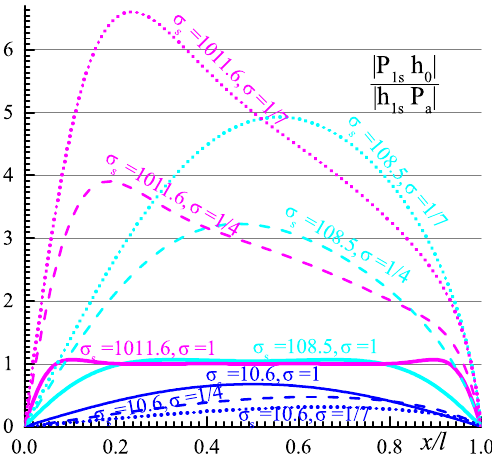
Figure 10. Distribution of P 1s inside of the 1D parallel slider with high-pressure in the left.